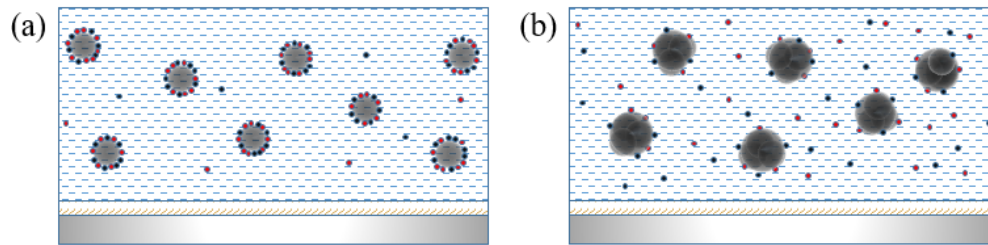
Figure 8. ( a ) γ -Fe 2 O 3 nanoparticles doped at low concentrations and ( b ) γ -Fe 2 O 3 nanoparticles doped at relatively high concentrations.